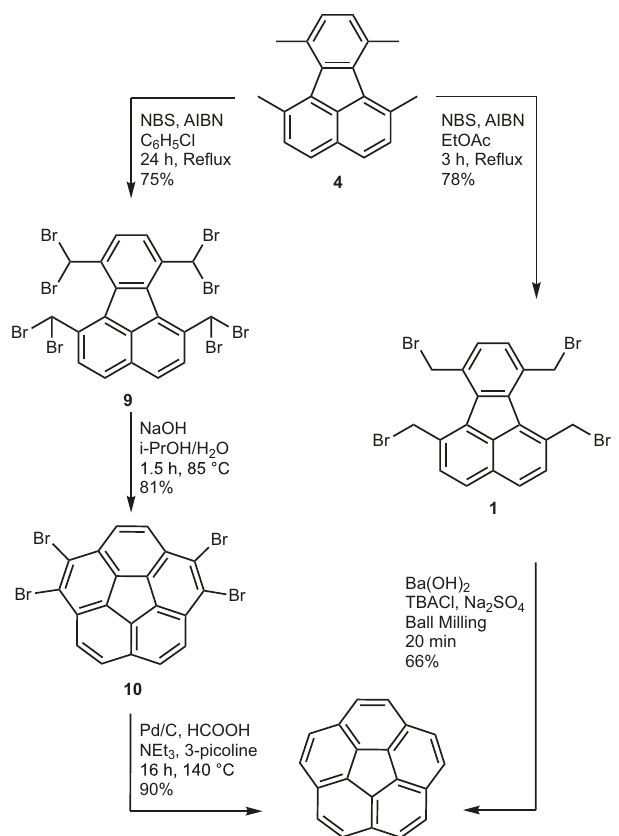
Fig. 9 Comparison of solution and mechanochemical synthetic pathways to corannulene. A comparison of the present synthesis (right) with the optimized kg scale solution-phase synthesis (left) of corannulene reproduced using the procedures provided in Butter fi eld et al. 55